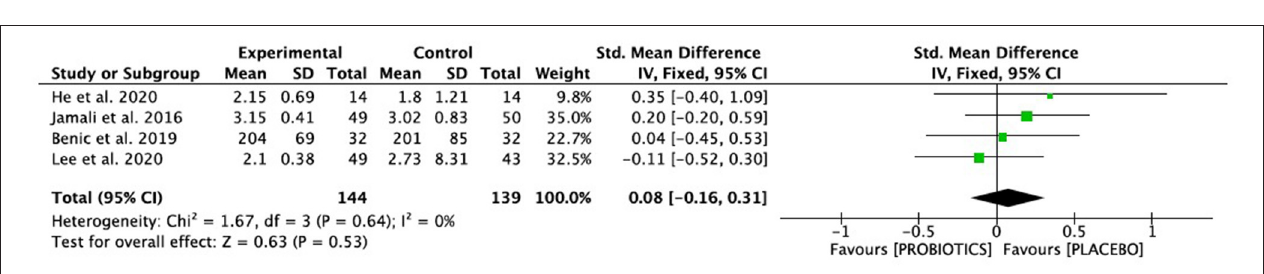
FIGURE 3 | The Cochrane Collaboration’s tool for assessing the risk of bias of included randomized controlled trials.